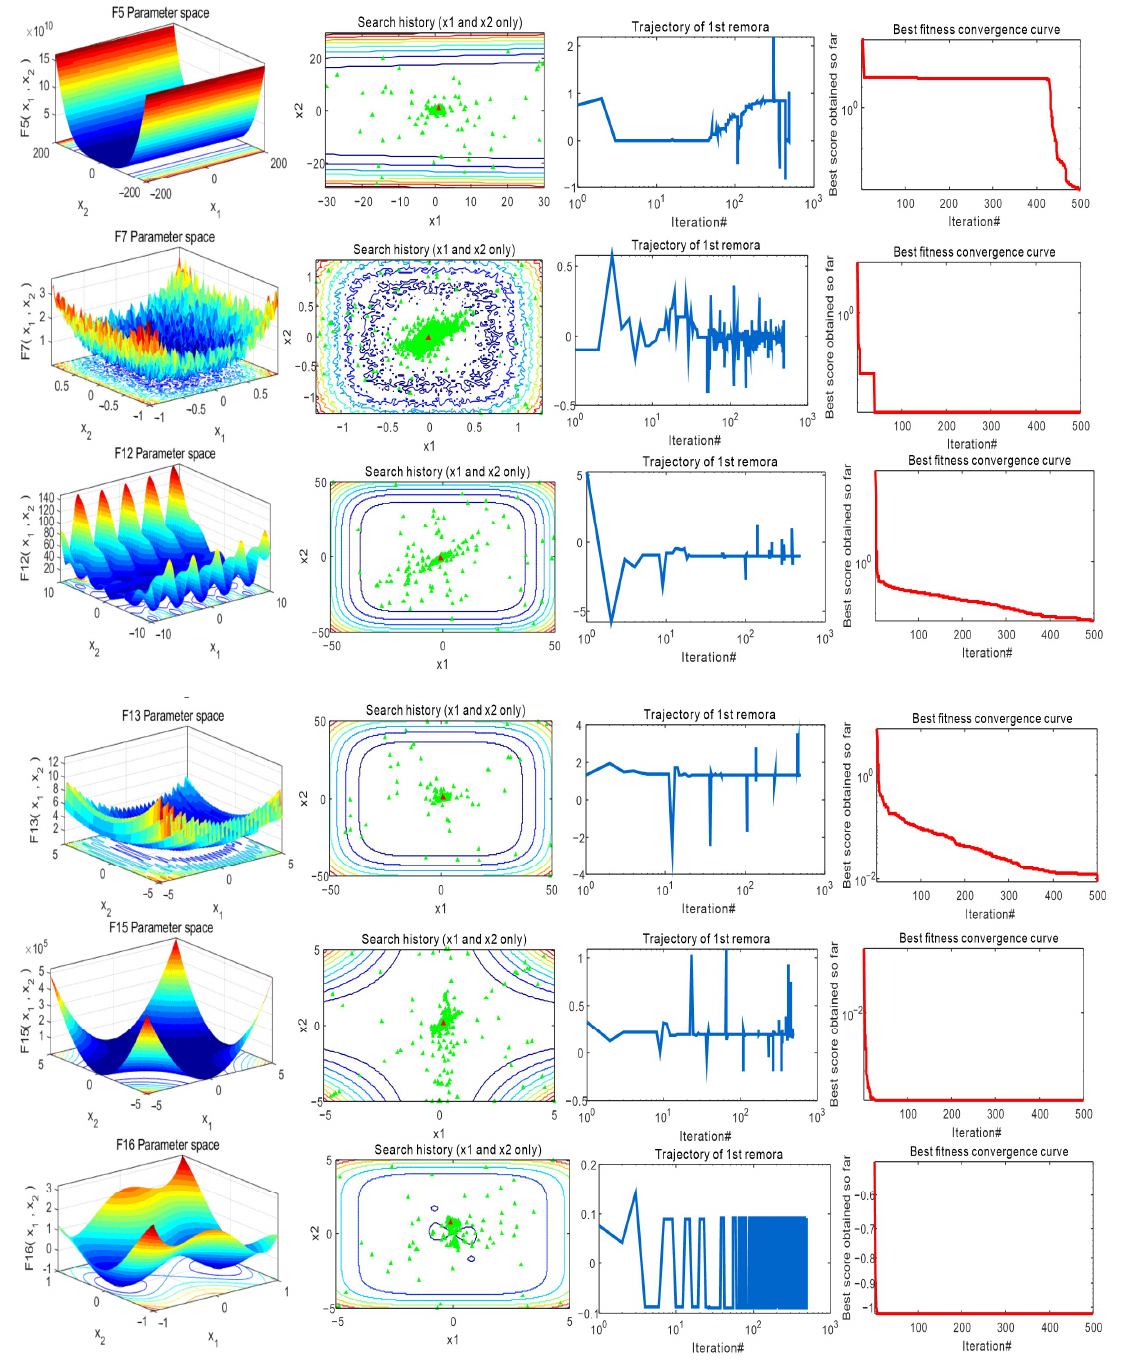
Figure 4. Quantitative measurement effect charts of functions (F1, F2, F3, F5, F7, F12, F13, F15, F16).